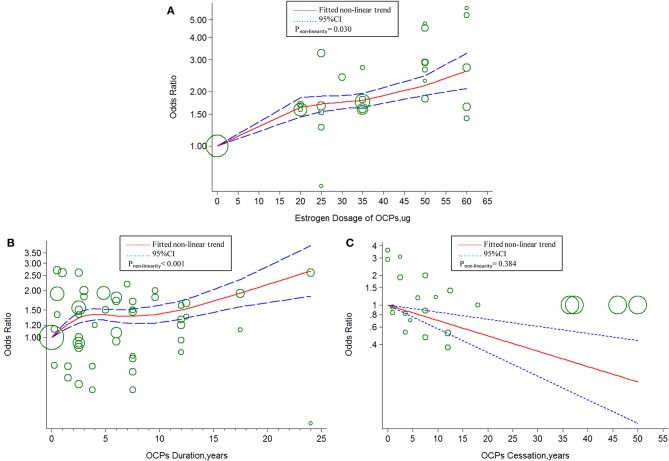
Dose-response relationship between OCPs [(A) estrogen dosage of OCPs, (B) OCPs duration, (C) OCPs cessation] and risk of total stroke. The circles represent the ORs in each individual study with the circular size reflecting the weight of corresponding study. OCP, oral contraceptives.